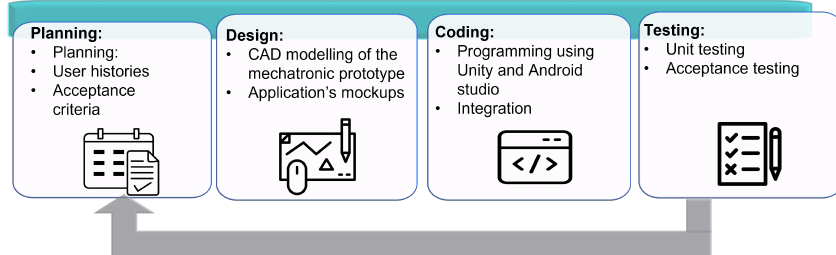
Figure 7. XP Methodology